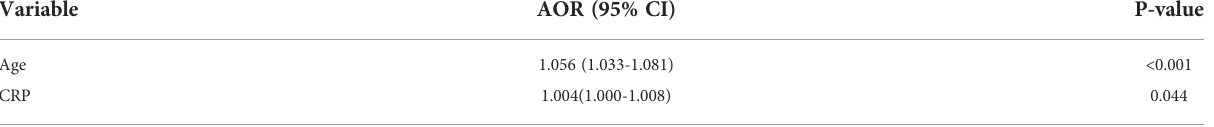
TABLE 9 Binary logistic regression analysis indicating factors associated with disease severity.